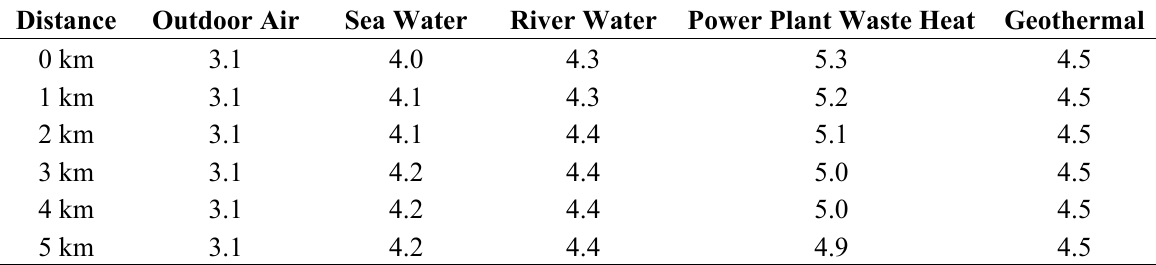
Table 6. Average COP on the representative day of each heat source according to distance